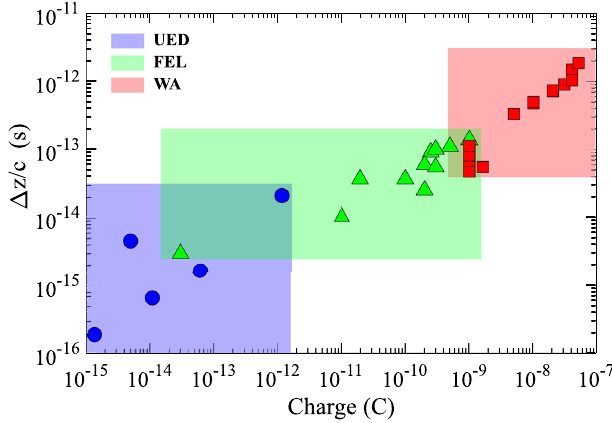
FIG. 3. Δ z calculated using beam parameters for existing facilities or design parameters from Refs. [15 – 28].